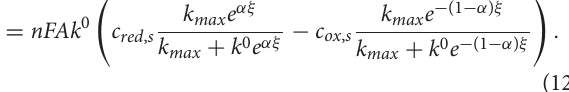
FIGURE 4 | Plot of the ordinate intercepts of the Koutecký-Levich plots at different concentrations of vanadyl sulfate vs. the inverse concentrations.